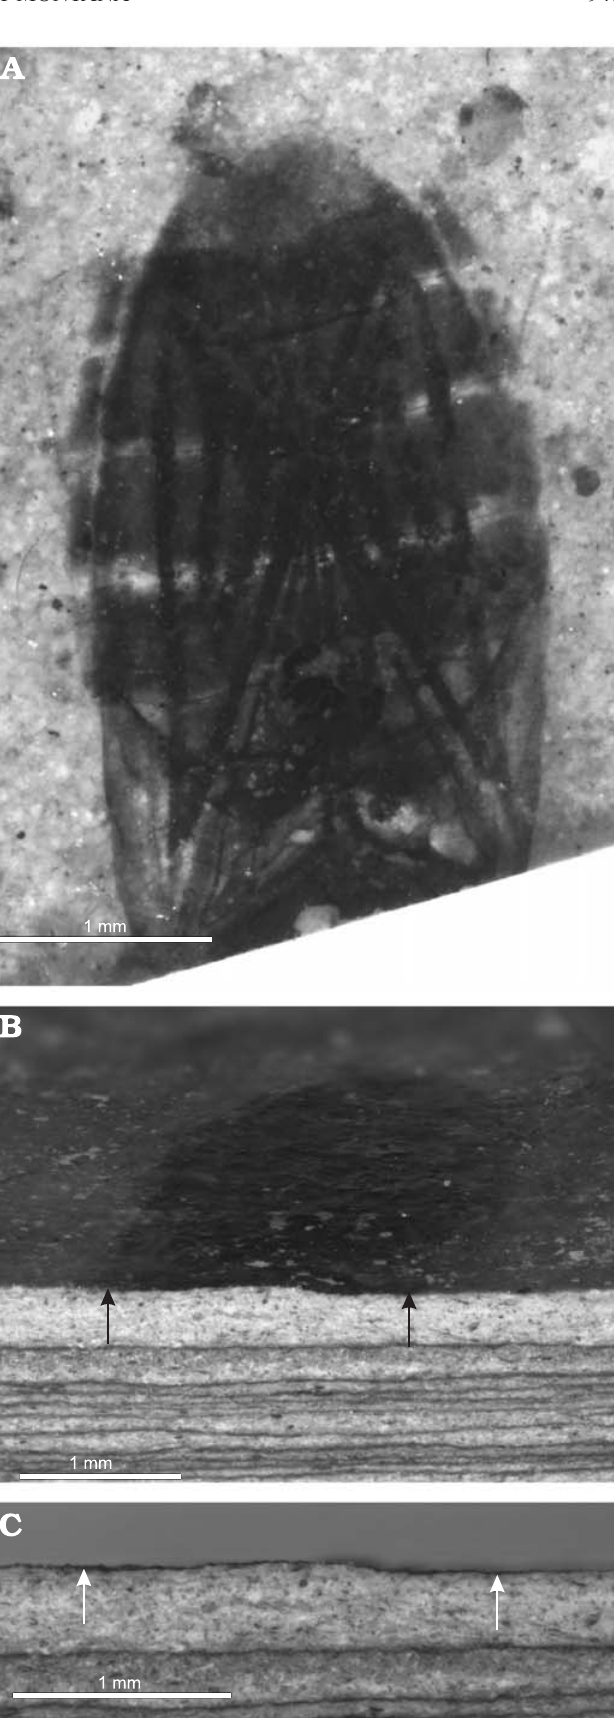
Fig. 12. A varve surface in shale (USNM 560104) from the Coal Creek member of the Kishenehn Formation, Eocene, Montana, USA, in which the fossi lized microbial mat contains a water boatman (Hemiptera: Corix- idae). A . A photograph of the fossil corixid immersed in ethanol. B . An oblique view of a cross-section of the dry specimen. Note the varves of widely variable thickness. The corixid (between the arrows) is on the sur- face of the rhythmite within the microbial mat. C . Cross-section showing the only slightly thickened mat at the site of the corixid fossil